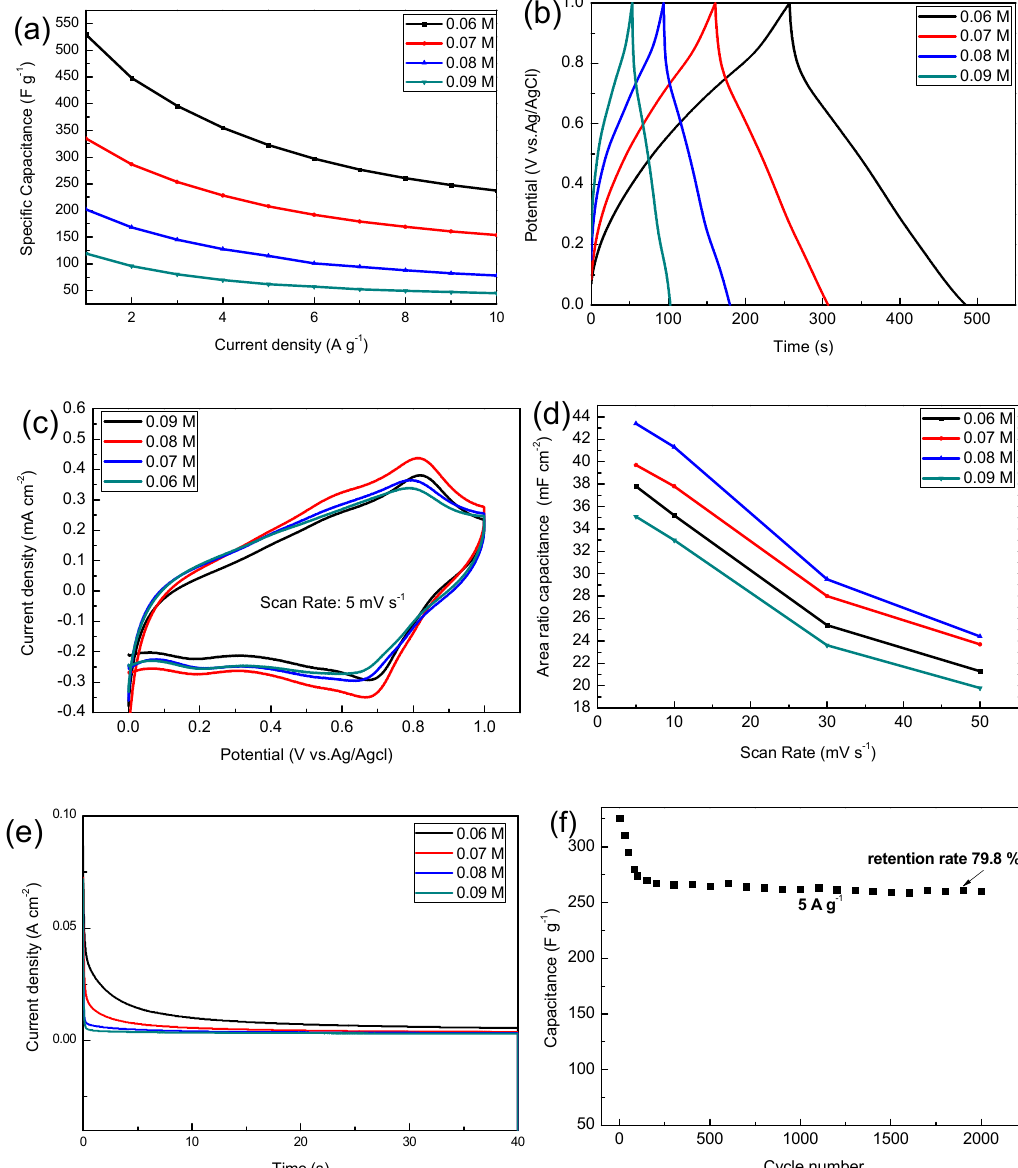
Figure 5. ( a ) The variations of specific capacitances of different current densities; ( b ) the charge and discharge time curve at a current density of 2 A g − 1 ; ( c ) the cyclic voltammetry (CV) curves at a scan rate of 5 mV s − 1 ; ( d ) area specific capacitance at different scan rates; ( e ) chronoamperometric response of different MnO 2 electrodes; ( f ) cycling performance of MnO 2 (0.06M) at a current density of 5 A g − 1 .